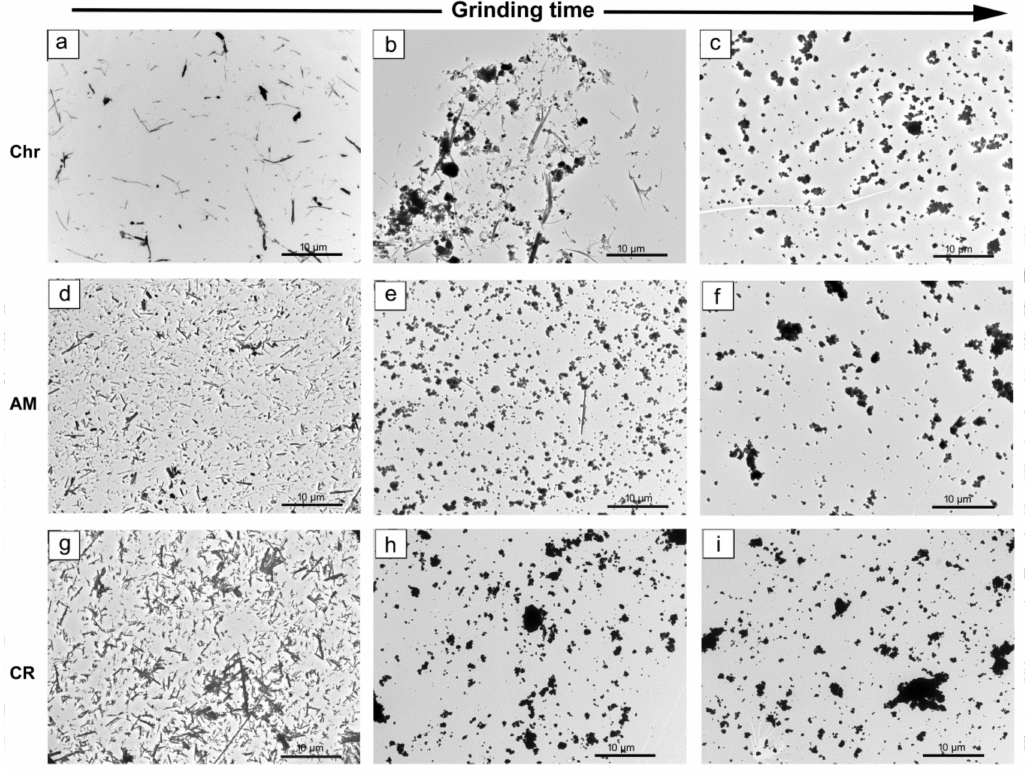
Figure 8. TEM images of: chrysotile ( a – c ); amosite ( d – f ); crocidolite ( g – i ). 30 s grinding ( a , d , g ); 5 min grinding ( b , e , h ); 10 min grinding ( c , f , i